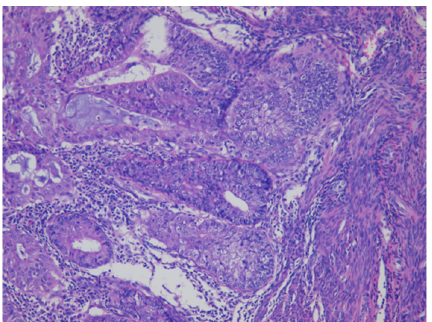
Figure 3. The absence of stromal cells in between tumor and myometrium hints the superficial myometrial invasion (200× magnification).